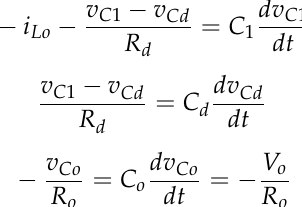
Figure 3. Equivalent circuits of the bridgeless SEPIC PFC converter with the damping circuit: ( a ) when S c is turned on; ( b ) when S c is turned off.